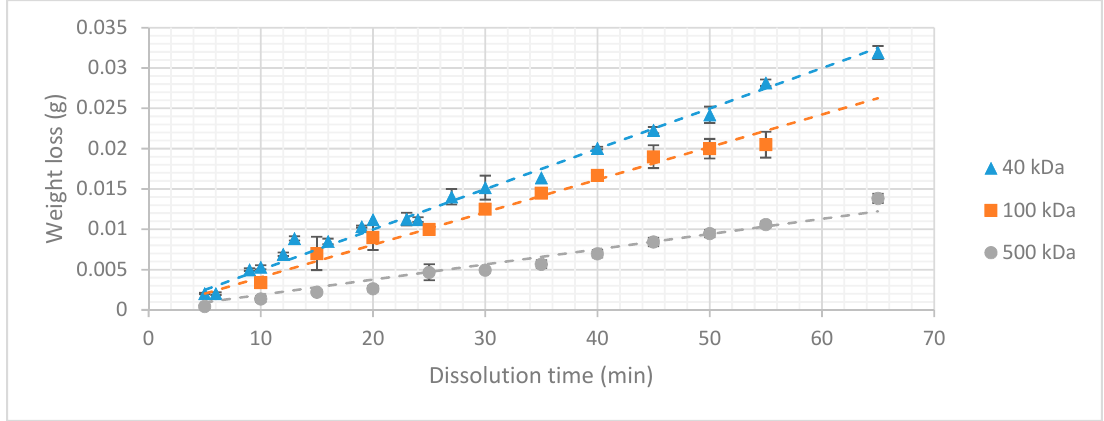
Figure 5. Weight loss in function of dissolution time ( n = 6).